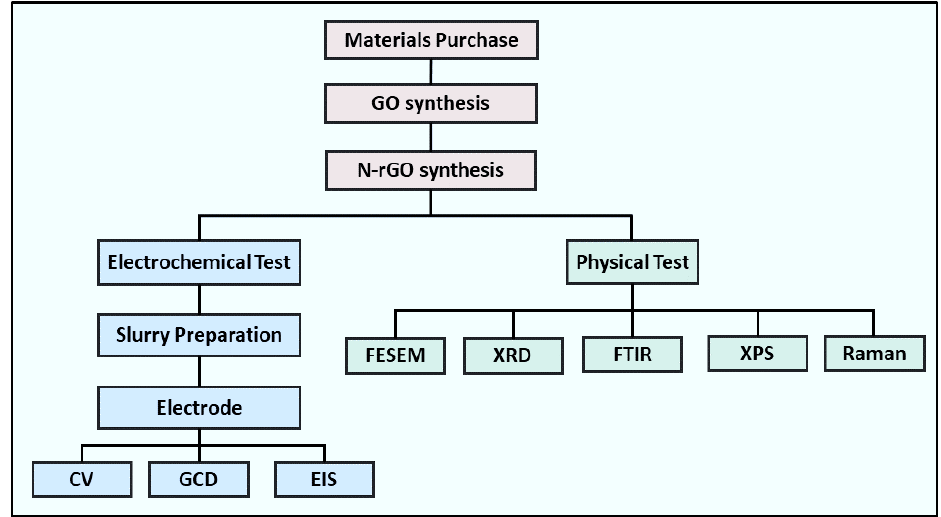
Figure 2. The flowchart displays the entire process of the optimization and performance tests of electrode materials.